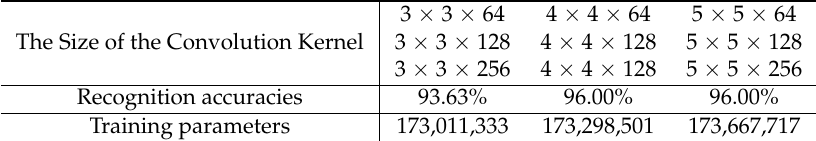
Table 3. Recognition accuracies vs. Size of the convolution kernel.